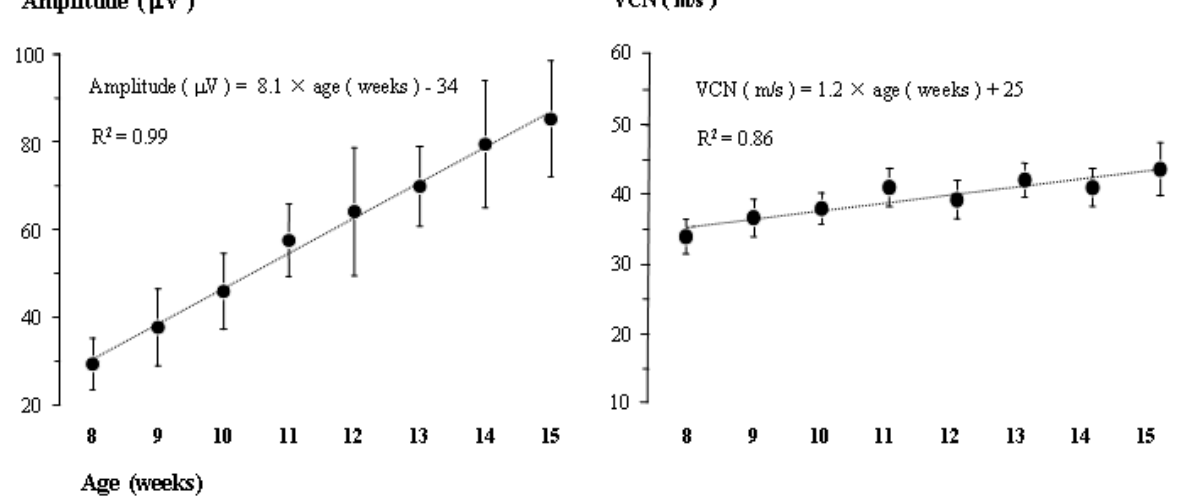
FIGURE 2 – Mean ± standard deviation of the SNAP amplitudes (left side) and NCV (right side) between the 8th and the 15th week of animal life. The equation of linear regression relating amplitude (µV) or NCV (µV) and age (weeks) and the squared correlation coefficient (R 2 ) is